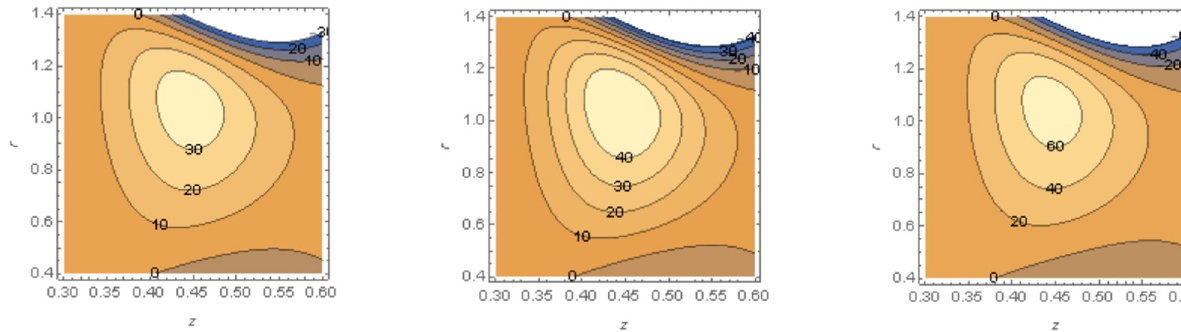
Figure 19: Various values of the wave frame streamlines of Q 1 = { 0.10, 0.11, 0.12 } at